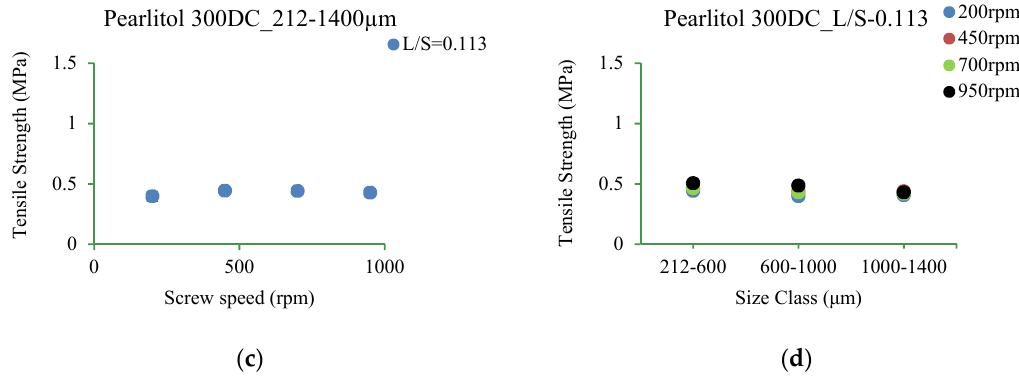
Figure 20. Tensile strength of tablet of granules at different size classes of Pearlitol 300DC. ( a ) 212–